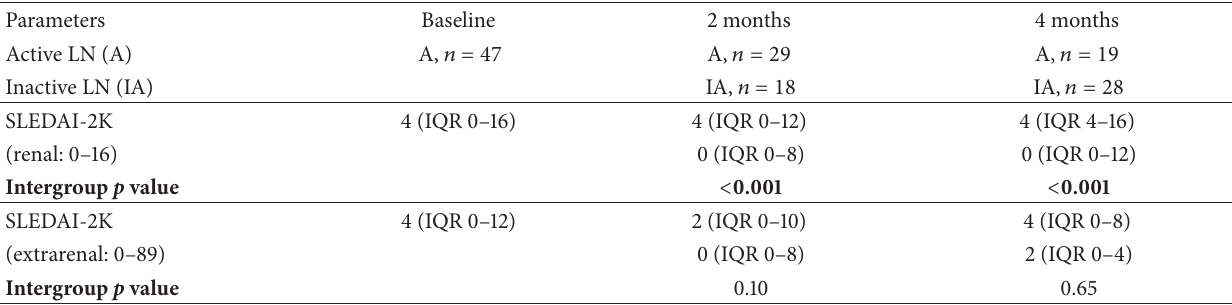
Table 6: Area under the curve (AUC) of ROC curves for uMCP-1 and standard biomarkers for LN activity on longitudinal follow-up.